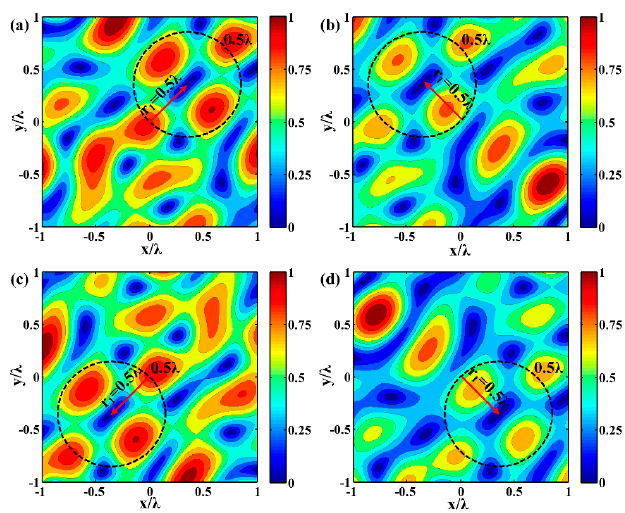
Figure 4. Spatial transformation of the synthesized sound field with an appointed distance 0.5 λ along different directions. ( a ) 45 ◦ , ( b ) 135 ◦ , ( c ) 225 ◦ , and ( d ) 315 ◦ .